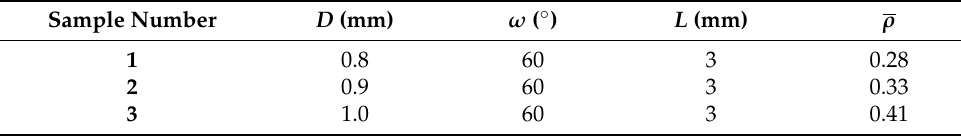
Figure 1. ( a ) The unit cell of the 3-D pyramid lattice material, ( b ) periodic 3-D pyramid lattice material, ( c ) aluminium pyramid lattice material. Table 1. Structural parameters of the pyramidal unit cell. Table 1. Structural parameters of the pyramidal unit